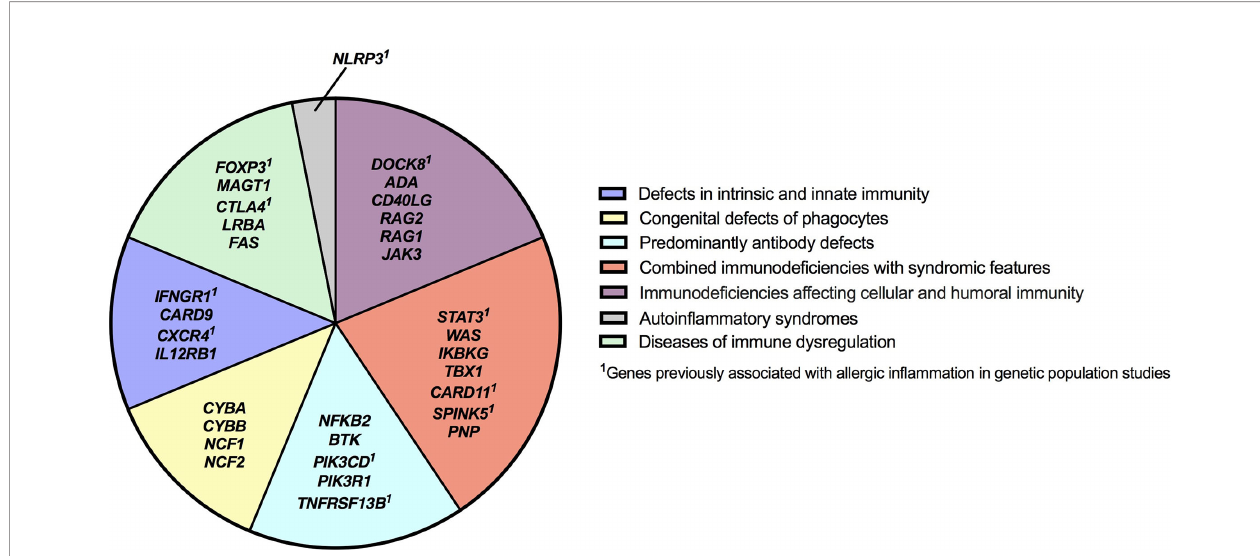
FIGURE 4 | Inborn errors of immunity genes associated with type 2 in fl ammation by disease category. IEI genes found to be associated with type 2 in fl ammation in our study are categorized according to IUIS Phenotypic Classi fi cation. HGNC gene symbols are